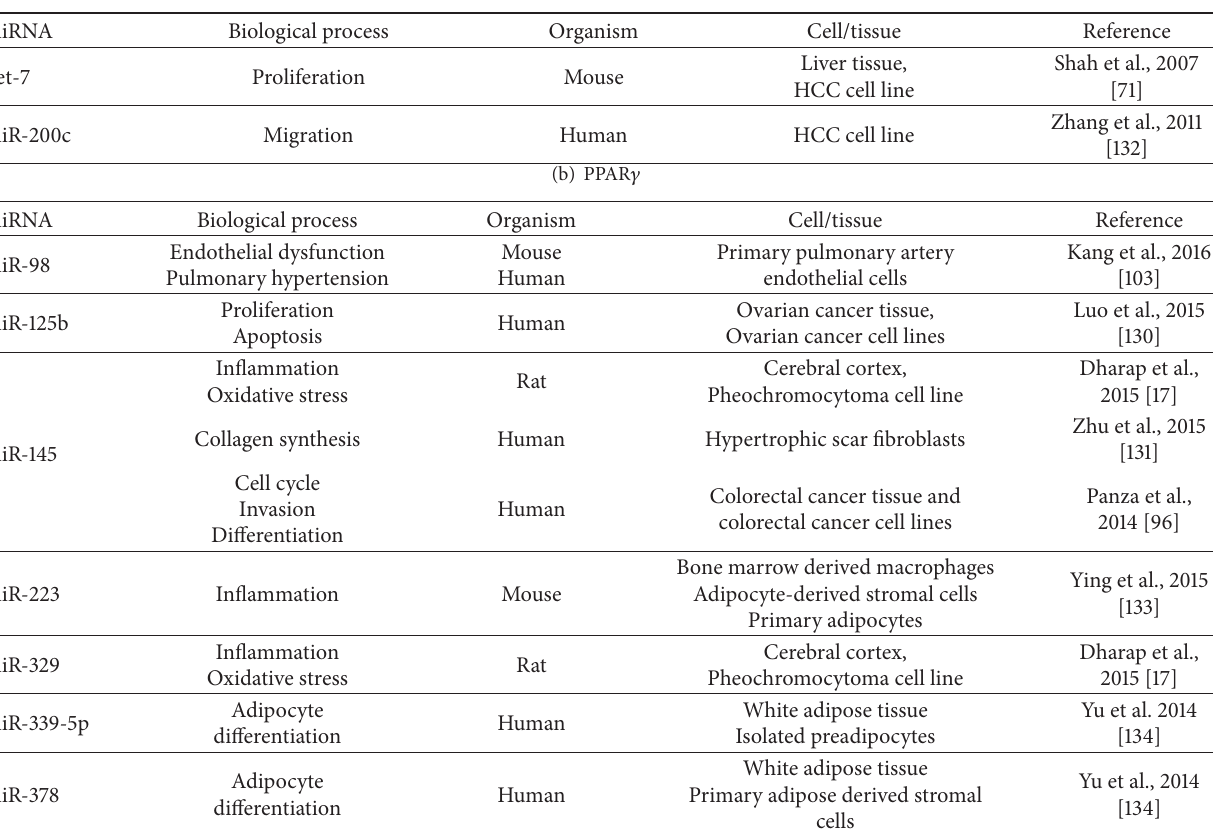
Table 2: PPAR 𝛼 - and PPAR 𝛾 -dependent miRNAs induction in specific tissues and pathophysiological